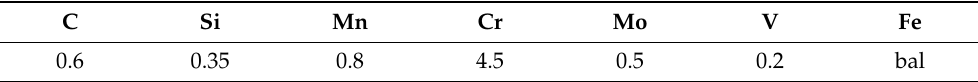
Table 1. Chemical composition of workpiece material (% w / v